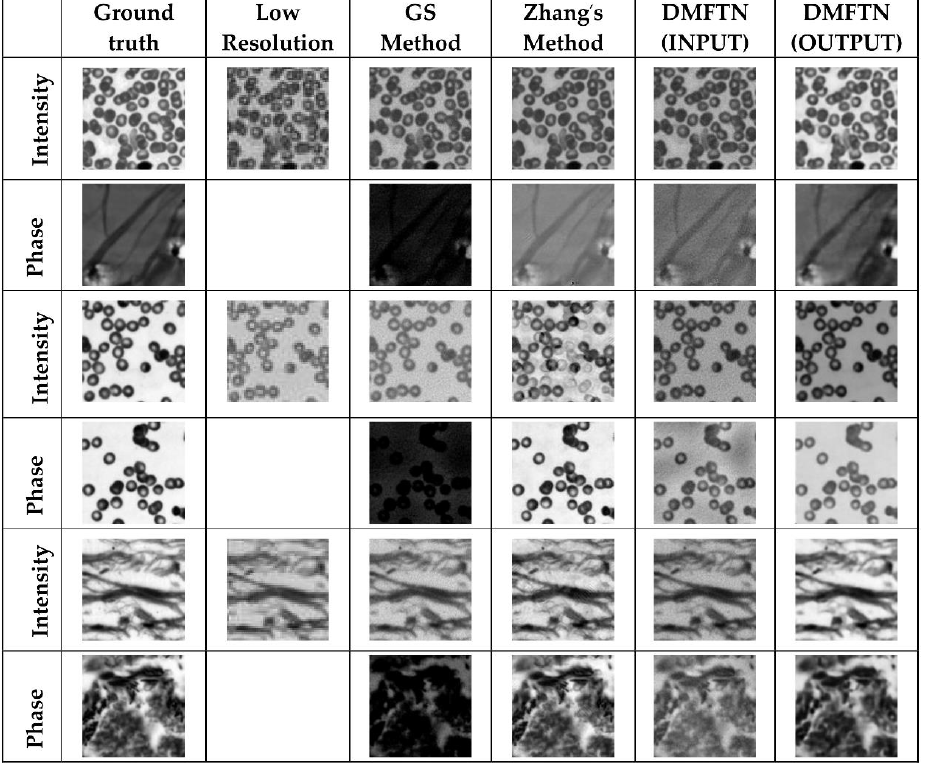
Figure 10. Reconstruction results under the same noise.